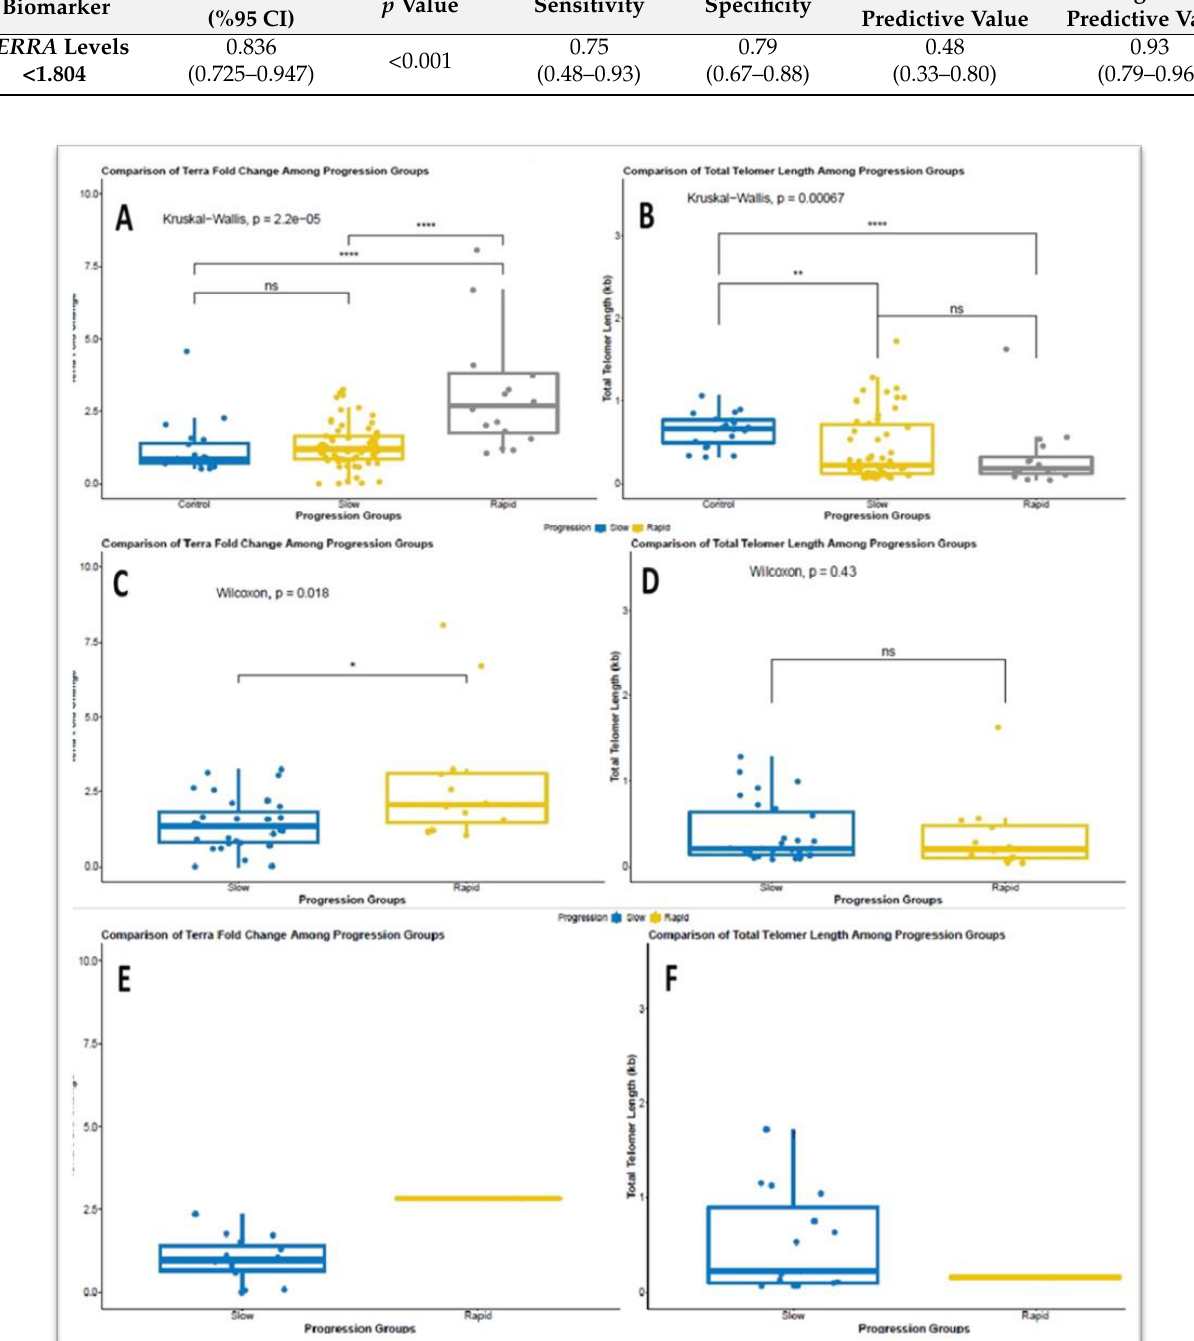
Figure 4. Assessment of normal and rapid progression in terms of TERRA levels extracted from the DNA:RNA hybrid fraction in all ADPKD patients compared to controls (**** p = 2.2 − 5 ) ( A ). Assessment of normal and rapid progression in terms of telomere length in all ADPKD patients compared to controls (** p = 0.000067) ( B ). Assessment of normal and rapid progression in terms of TERRA levels extracted from the DNA:RNA hybrid fraction in ADPKD patients with PKD1 mutation(* p = 0.018) ( C ). Assessment of normal and rapid progression in terms of telomere length in ADPKD patients with PKD1 mutation(ns, p = 0.43) ( D ). Assessment of normal and rapid progression in terms of TERRA levels extracted from the DNA:RNA hybrid fraction in ADPKD patients with PKD2 mutation ( E ). Assessment of normal and rapid progression in terms of telomere length in ADPKD patients with PKD2 mutation ( F ).